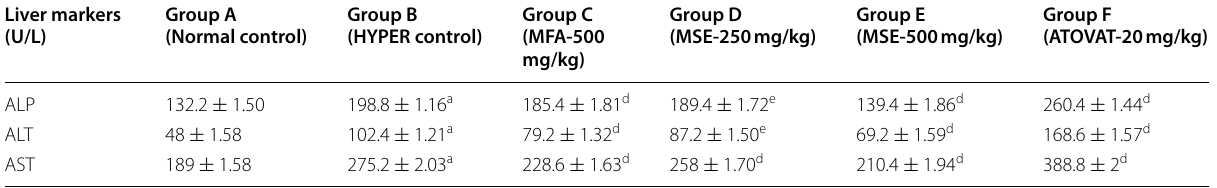
Table 1 Relation between different conc. of MM plant extracts and drug to livers Liver markers